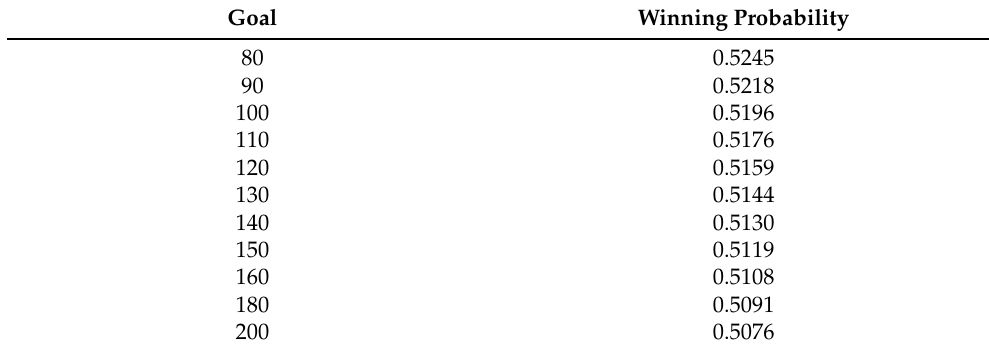
Table A1. Detailed winning probabilities of the first player when both players play optimally, for the standard two-dice Pig game.